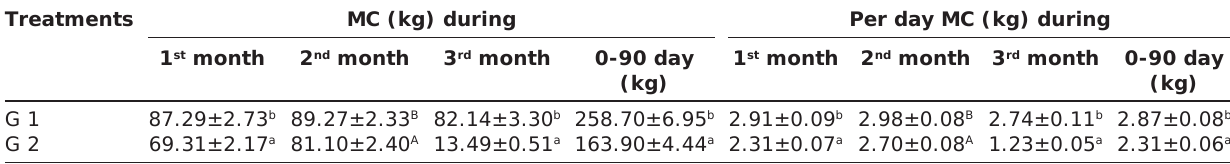
Table-3: Least squares’ means for overall monthly and per day (of different durations) MC up to 90 days. Treatments MC (kg) during Per day MC (kg)